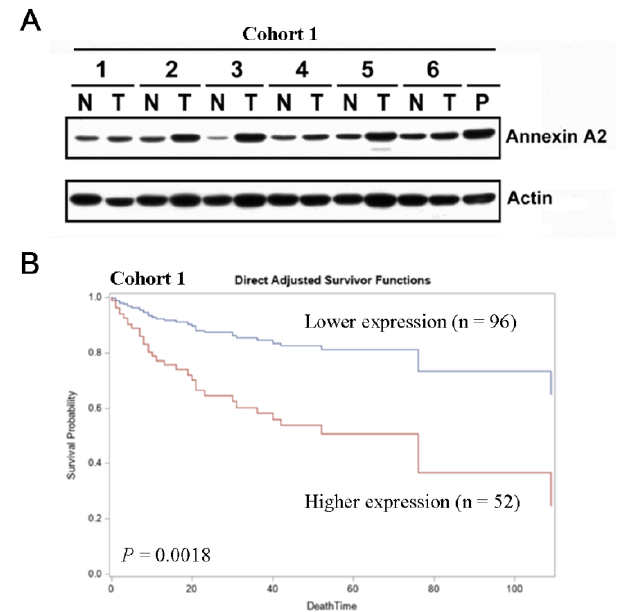
Figure 1. ANXA2 is clinically relevant in HCC. ( A ) Protein levels of ANXA2 in tumor tissues (T) and non-tumor tissues (N) were determined by Western blotting. P : positive control. ( B ) Kaplan–Meier survival curves with log-rank test stratified by high ANXA2 expression (higher T/N ratio ≥ 0.8) and low ANXA2 expression.